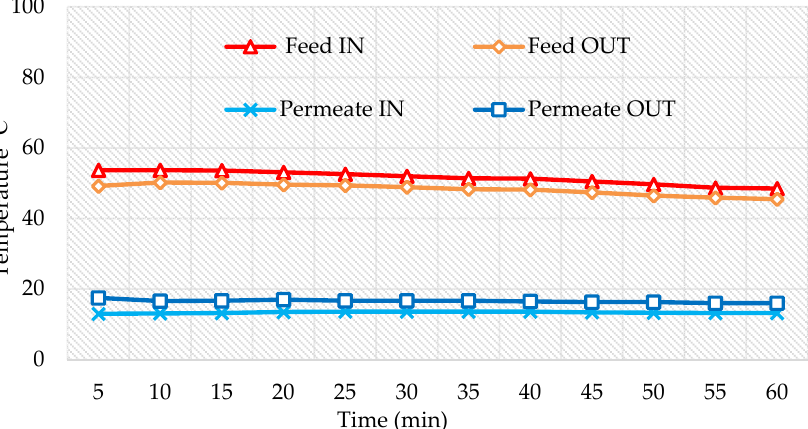
Figure 9. Feed and permeate temperature in case of the empty channel by using 5 L/min.